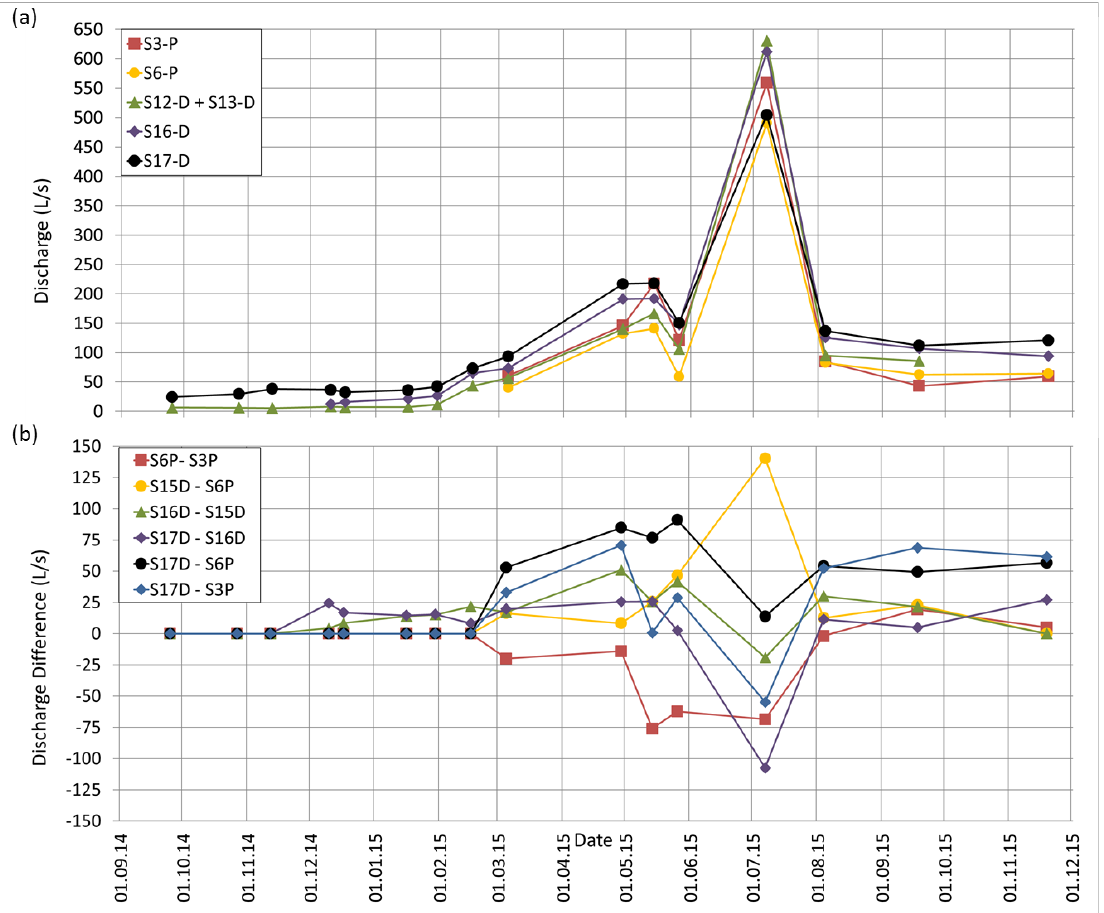
Figure 7. Variation in ( a ) stream discharge at the monitoring sites; ( b ) difference in discharge between adjacent sites (positive values indicate increasing discharge in the downstream direction).